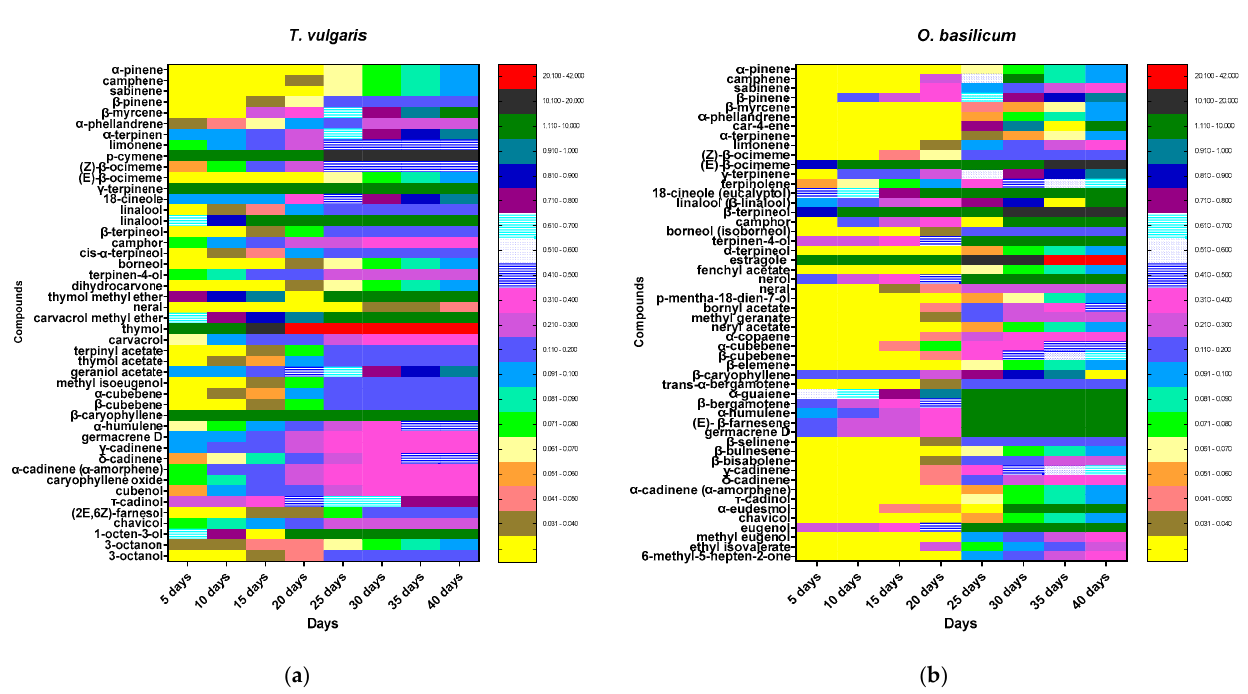
Figure 3. Heatmap of ( a ) T. vulgaris and ( b ) O. basilicum cell suspension extracts during initiation time (40 days) analyzed by GC-MS. Secondary metabolites were displayed as colors ranging from yellow to red (as shown in the key).